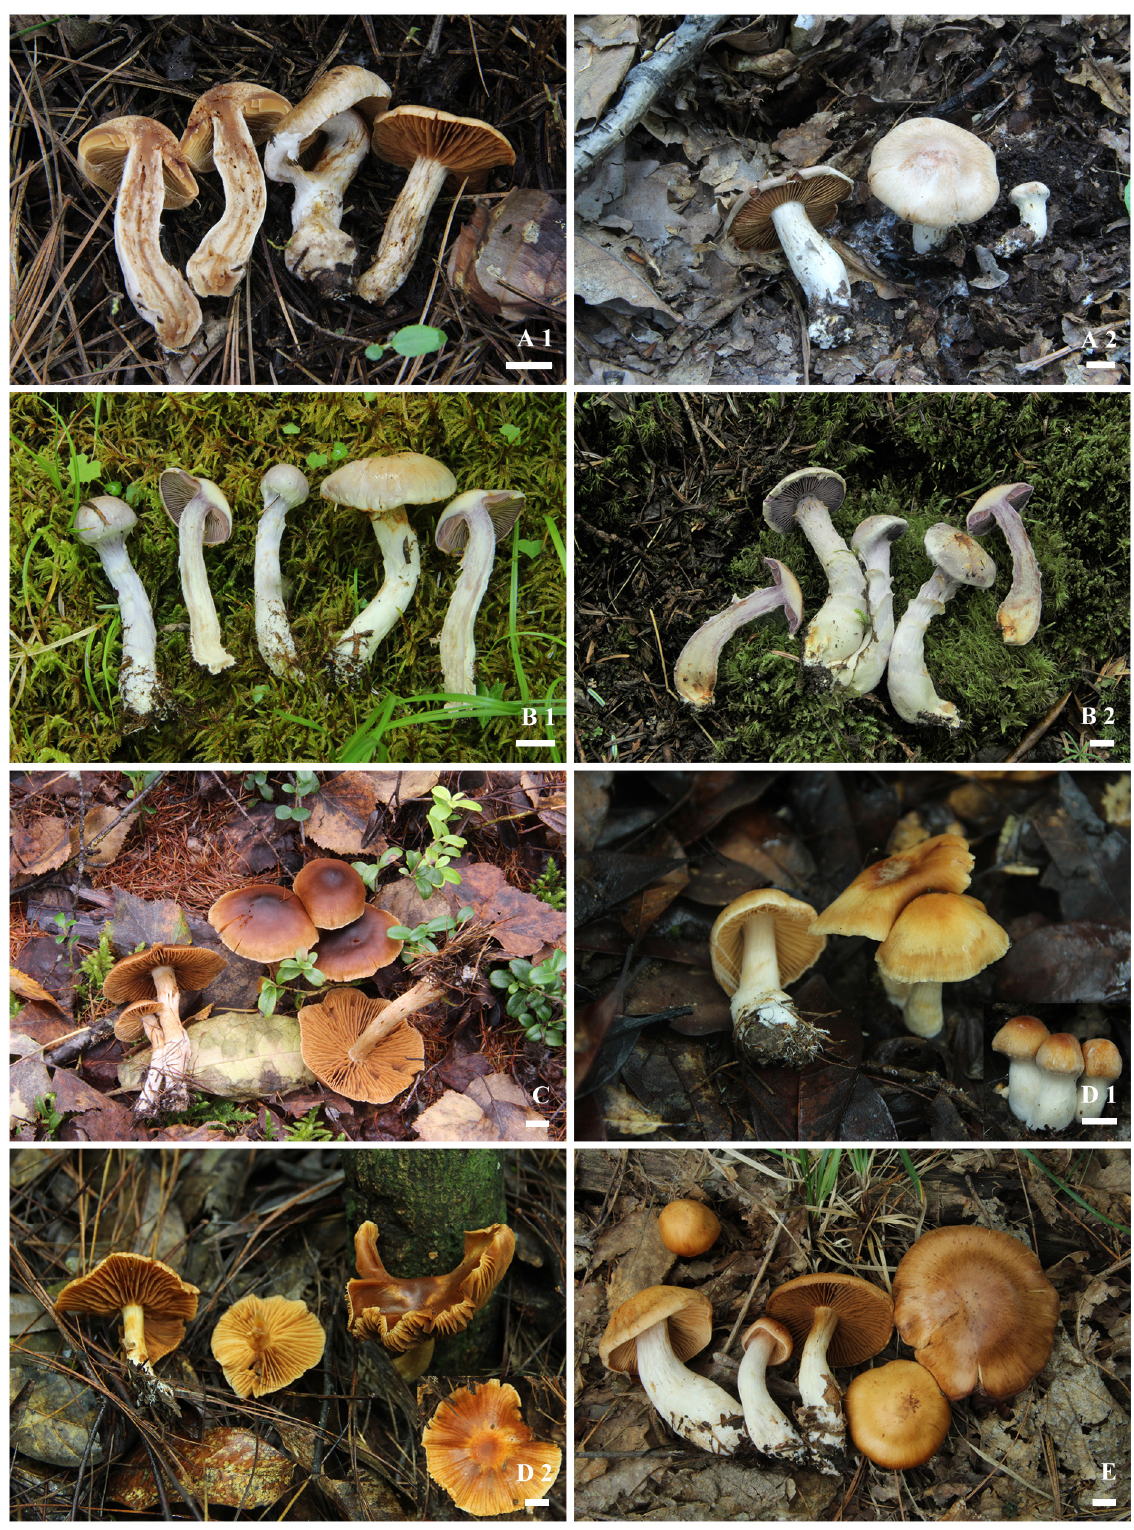
Figure 2. Basidiomata of Cortinarius neobalaustinus : ( A1 ) HMJAU58951, holotype, ( A2 ) HMJAU58948; C. pseudocamphoratus : ( B1 ) HMJAU48698, holotype, ( B2 ) HMJAU48795; C. subnymphatus : ( C ) HMJAU48633, holotype; C. wuliangshanensis : ( D1 ) HMJAU58940, holotype, ( D2 ) HMJAU58943; C. yanjiensis : ( E ) HMJAU58947, holotype. Bars = 10